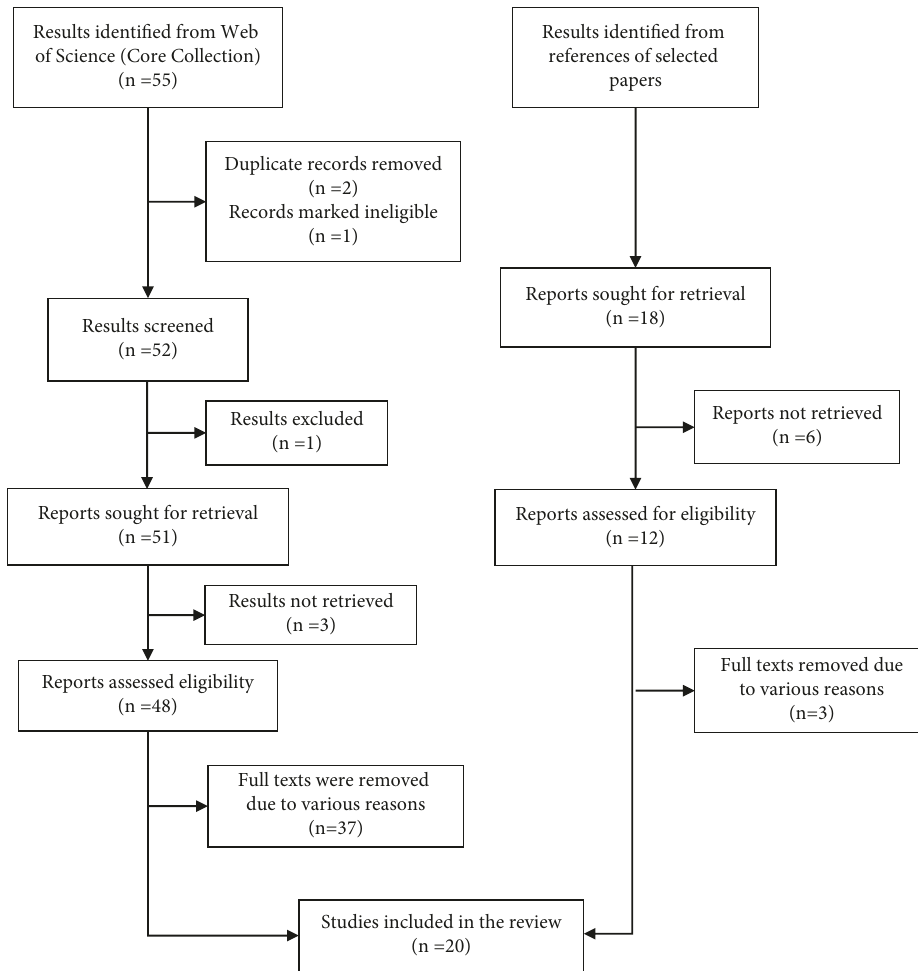
Figure 1: A flowchart of literature